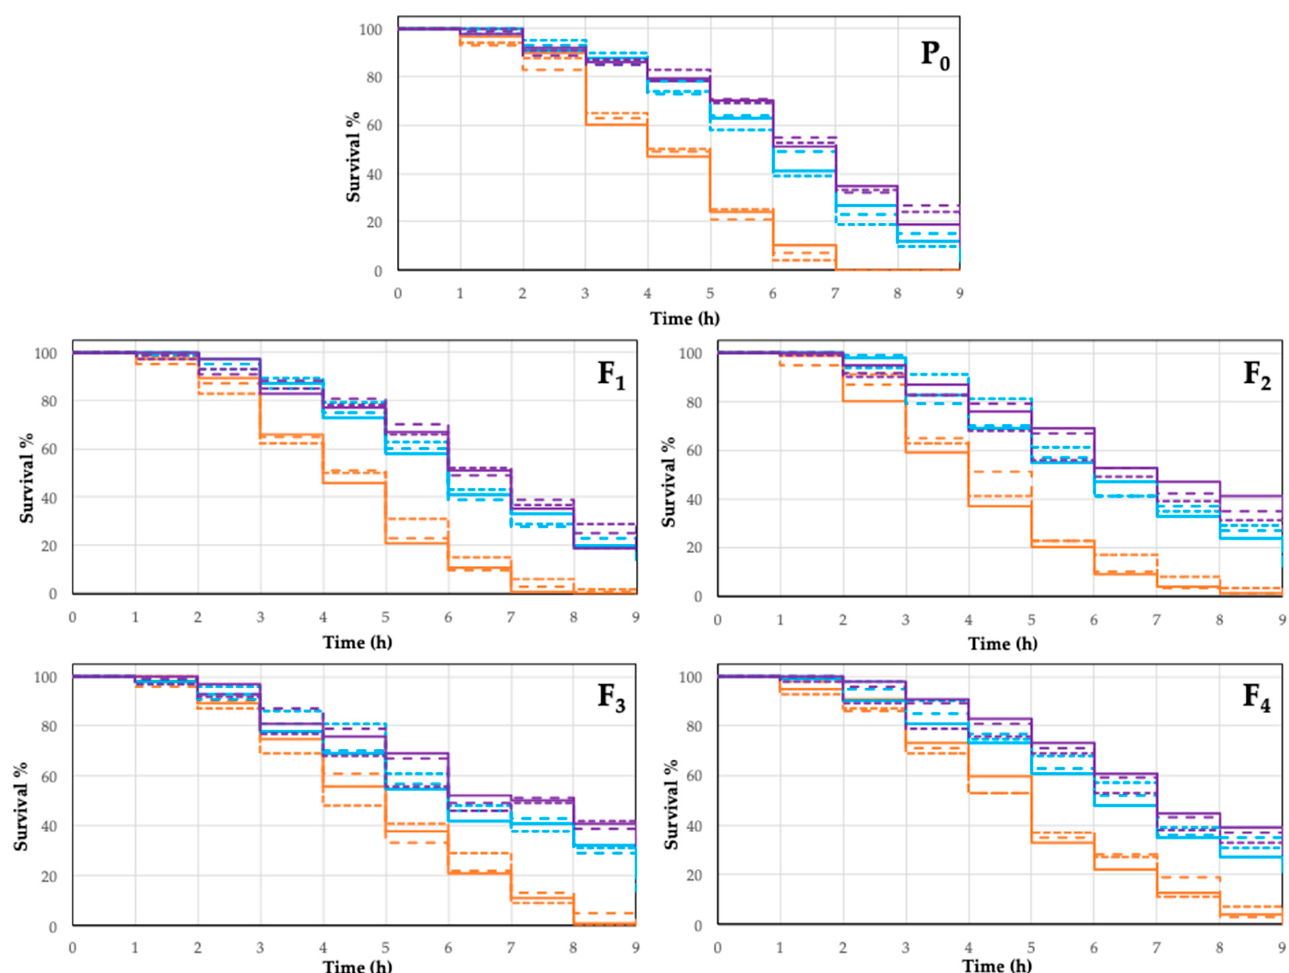
Figure 5. Comparison of the survival rate of Caenorhabditis elegans treated with 50 µM anthocyanins extracted from coffee ( Coffea arabica L.) husks using ethanol as the extracting agent. Fifty µM antho- cyanin conjugates from the same extract attached to zinc oxide nanoparticles [fresh (purple) and after 12 weeks (light blue)] and exposed to oxidative stress conditions (10 mM H 2 O 2 ). All treatments were compared versus the control group (orange), which did not receive any treatment. The effects of the anthocyanins were analyzed in the parental line (P0) and four offspring generations (F1, F2, F3, and F4). The data shown correspond to three independent